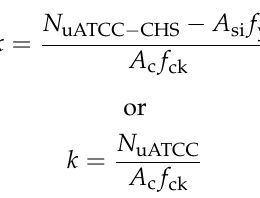
Figure 7. Stiffness comparison.